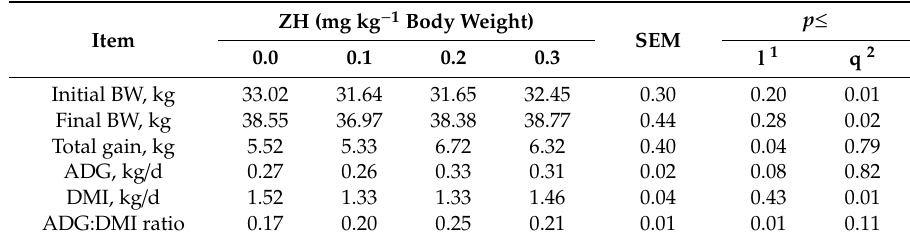
Table 2. Feedlot performance of hair-breed lambs supplemented with di ff erent levels of zilpaterol hydrochloride (ZH) during 29 d.